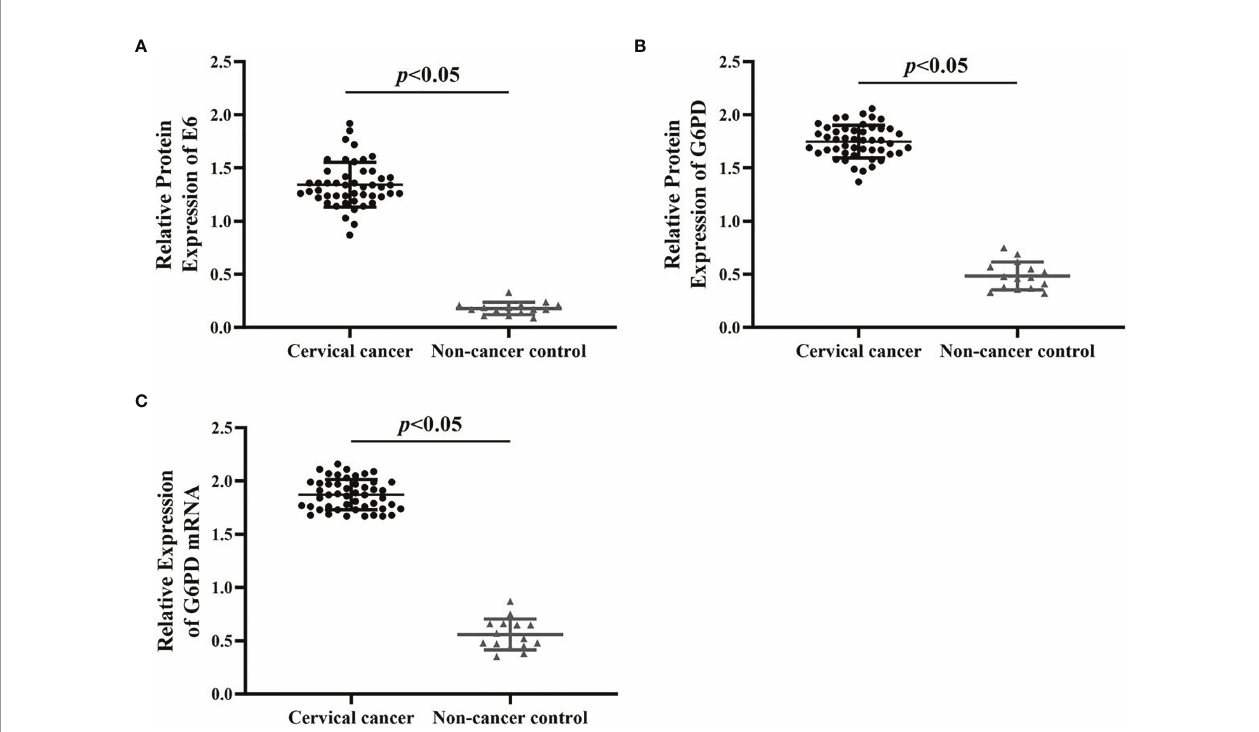
FIGURE 1 | The expression changes of HPV E6 and G6PD between the cervical cancer cases and normal control. The relative expression levels of E6 protein (A) , G6PD protein (B) , and G6PD mRNA (C) in cervical cancer patients ( n = 48) and non-cancer control ones ( n = 15) were shown in the scatter dot plots. The scatter points represented the original data of individuals within each group. The quantitative analysis of expression levels of E6 and G6PD showed statistical differences. Data are presented as means ± standard deviation